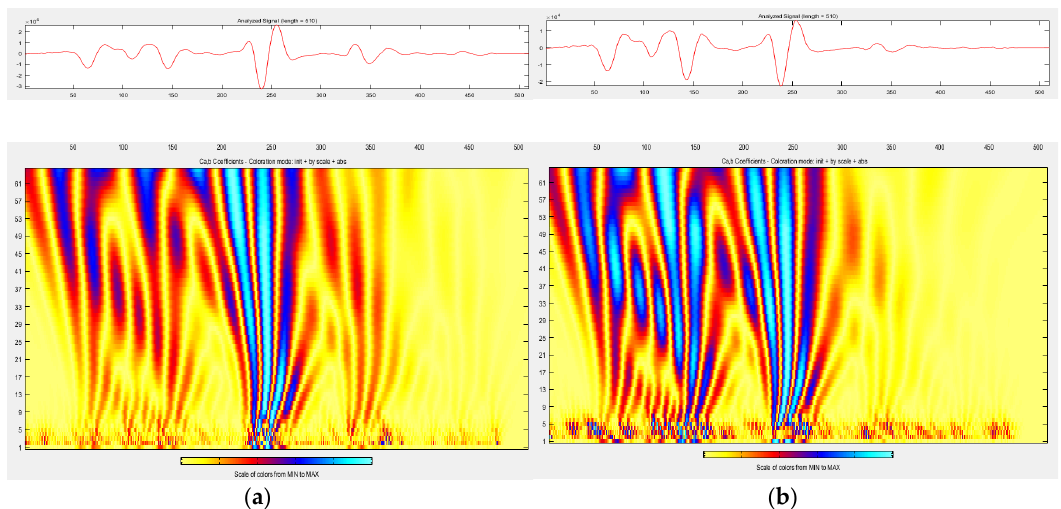
Figure 10. Wavelet analysis of A-scan from measurements in conditions ( a ) wV (temp. − 2 ◦ C, thin layer of fresh snow on the slab surface); ( b ) wVI (temp. − 2 ◦ C, de-icing salt on the slab